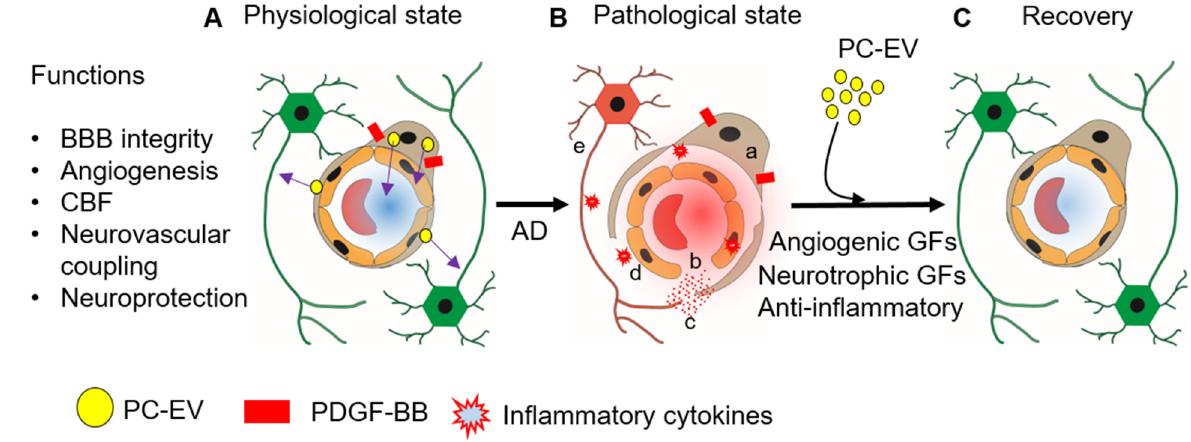
Figure 5. PC-EVs are essential for vascular health, blood–brain barrier integrity, and neuronal health. ( A ) PDGF-BB stimulated the release of PC-EVs to exert effects on neighboring ECs and neurons or through the bloodstream on distant cells. The transport of EVs is key for maintaining vascular and neuronal health. ( B ) Vascular disease associated with neurodegenerative disease, e.g., AD, is caused by, a; pericyte detachment and loss, b; EC death, c; BBB disruption, d; release of inflammatory cytokines, e; neuroinflammation and neuron death. ( C ) Delivery PC-EVs in certain disease